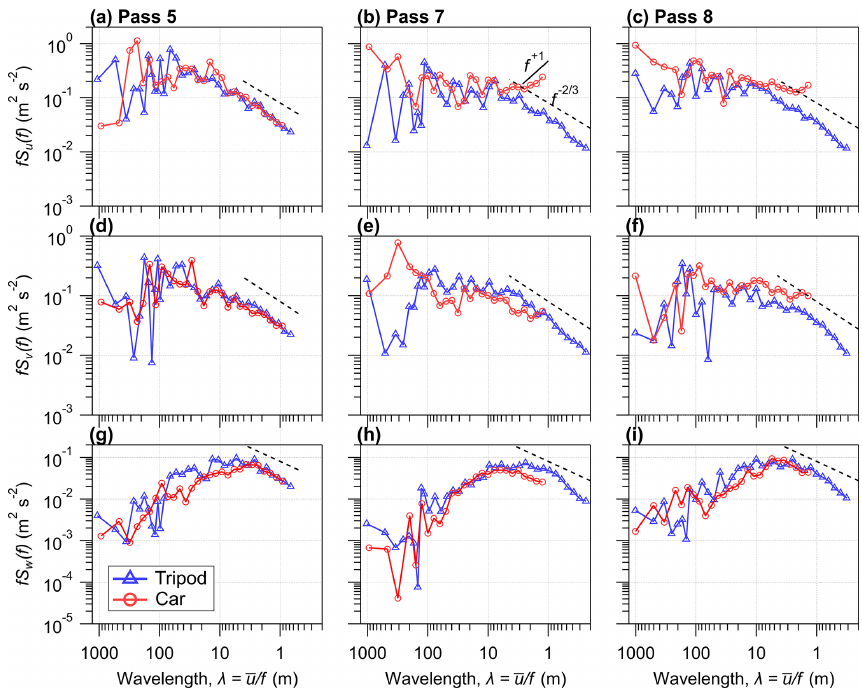
Figure 10. Binned power spectral density (multiplied by frequency) of the velocity components u (a–c) , v (d–f) , and w (g–i) , measured by the roadside tripod (triangles) and the mobile car (circles). The frequencies are normalized to give a wavelength ( λ ) as u/f , where f is the frequency (Hz) and u is the mean ambient wind speed (or car relative flow for the mobile car). Table 5. Statistics calculated over all measurement passes (i.e., Track #1 and Track #2), but with θ = 7.38 ◦ . MBE EC MBE W RMSE EC RMSE W Mean EC Mean W Mean EC car car